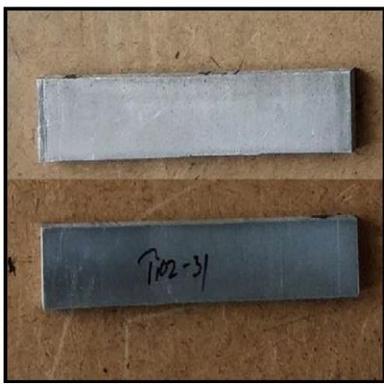
Dimensioned specimens (5 mm 10 mm 100 mm.